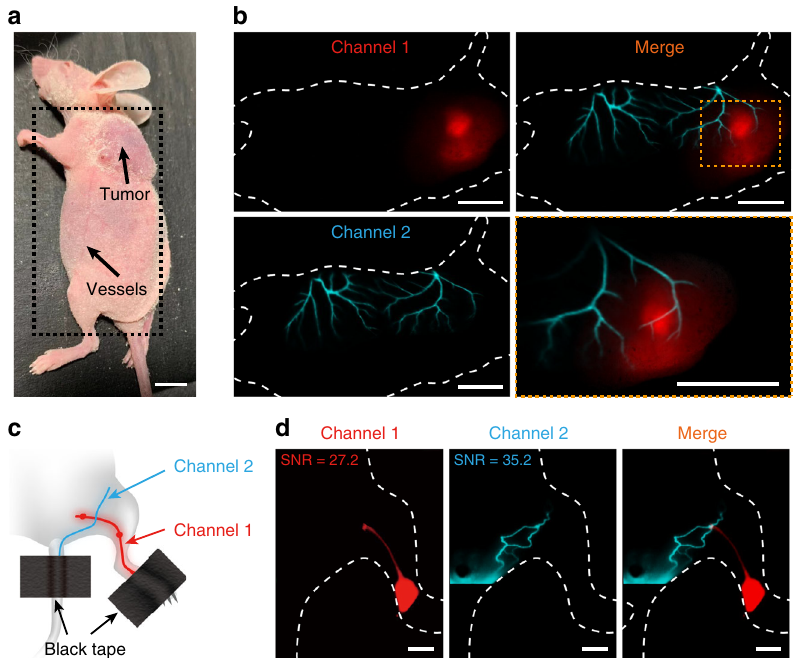
Fig. 6 In vivo multiplexed imaging using NIR-II-BPs. a Photograph depicting CT-26 tumor mouse for dual-channel bioluminescence imaging. Scale bar, 10 mm. b Dual-channel bioluminescence imaging of tumor tissue (upper left) and vessels (lower left) with NIR-I-BPs and NIR-II-BPs. The zoomed-in high- magni fi cation dual-channel image (lower right) displays fi ne structure between CT-26 tumor and vessels. Scale bar, 10 mm. c Schematic illustration of dual-channel bioluminescence imaging of lymph system. d Dual-channel bioluminescence imaging of lymph system with NIR-I-BPs and NIR-II-BPs. Scale bar, 5 mm. (Red channel 1: NIR-I-BPs, Cyan channel 2: